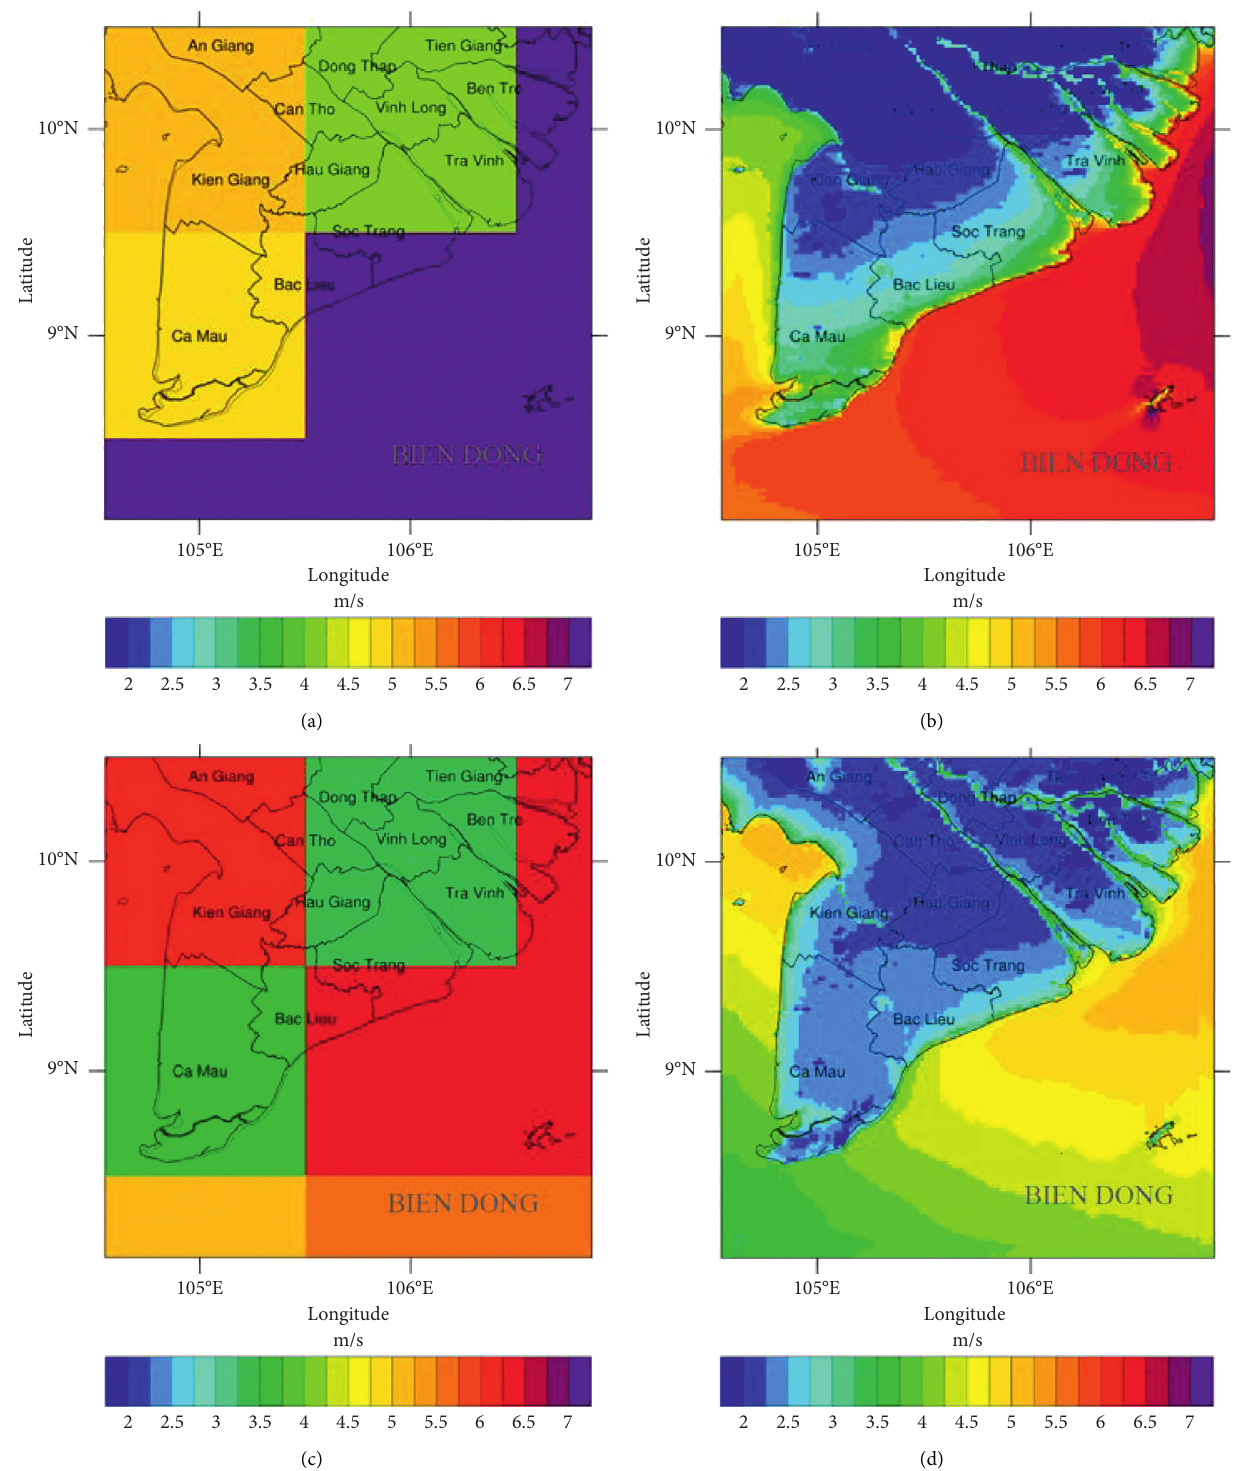
Figure 13: Mean wind speed at 10m height from FNL data (left) and WRF model at 2km resolution (right) for January (top) and July